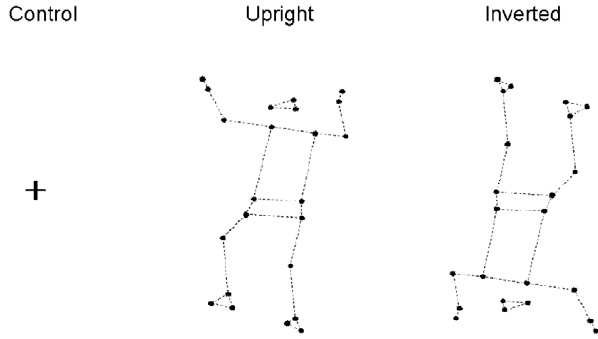
Figure 1. The three stimulus conditions. The Control stimulus was a little white cross presented against a black background. The Upright stimulus was a point-light display of a gymnast, oriented upright, trying to keep his balance on a rope (which was not represented). The biological humanoid was constituted of 23 azure dots (3 for the head, 2 for the pelvis, 1 for each hand, 2 for each foot and 12 for the main joints) presented against a black background. The Inverted stimulus was the same as the Upright one, but rotated 180 u around the barycentre of the dots. All stimuli lasted 11s. All displays were shown in reverse contrast and the underlying skeleton, indicated here by the dashed lines, was not represented.